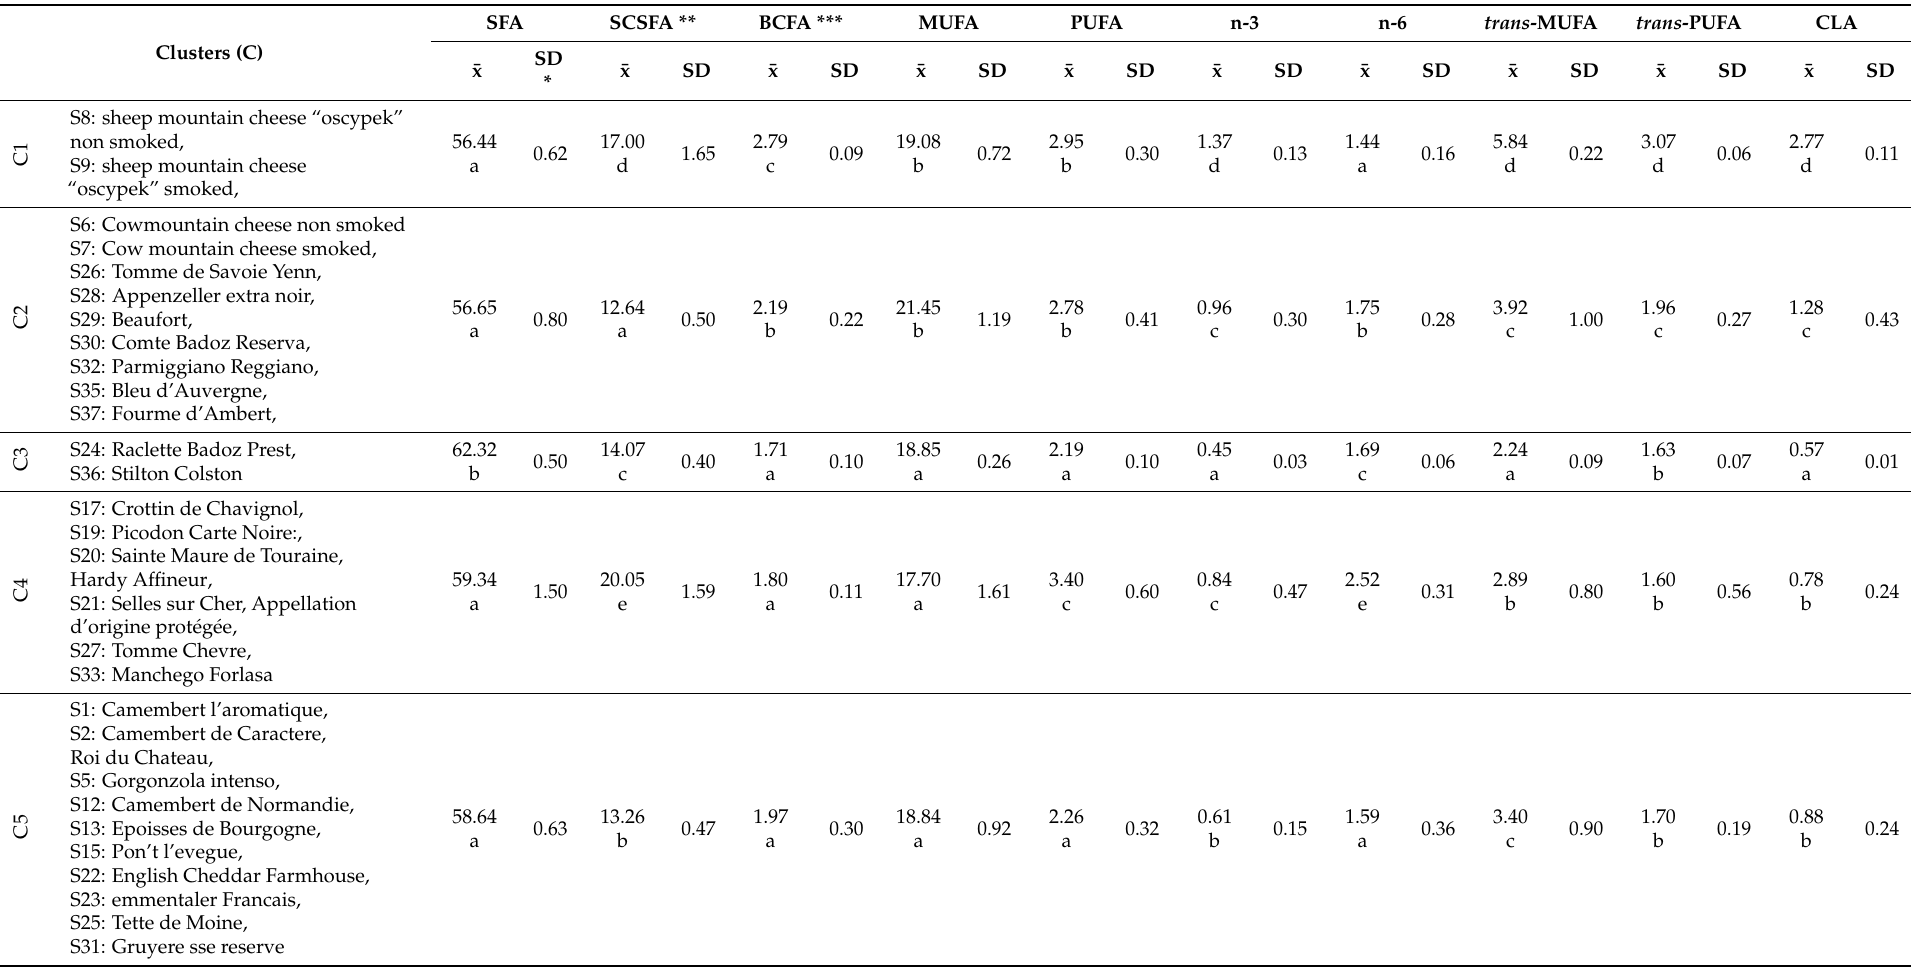
Table 3. Results of non-hierarchical analysis of group fatty acid content in studied commercial cheese samples, n = 320 [g 100 g − 1 ].